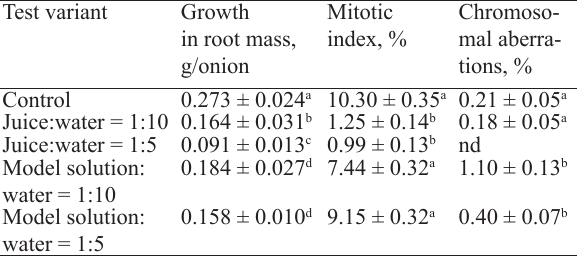
Table 2 Root mass growth, mitotic activity, and chromosomal aberrations of onion root meristem cells after two days of treatment with apple juice and model solution (n = 10) Test variant